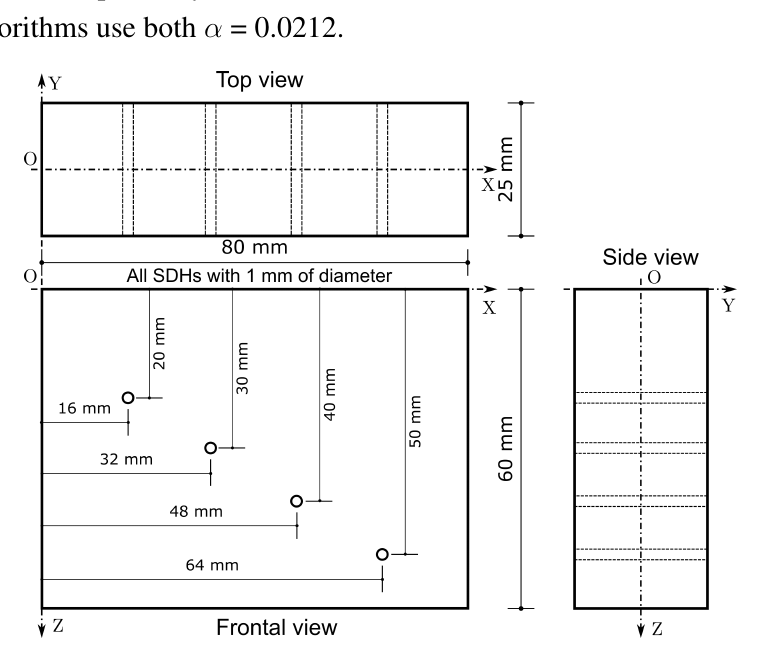
Figure 7. Geometry of the second inspected object. It was manufactured of steel and it has four SDHs with 1 mm of diameter centered at positions x ={16,32,48,64} mm and z = {20,30,40,50}